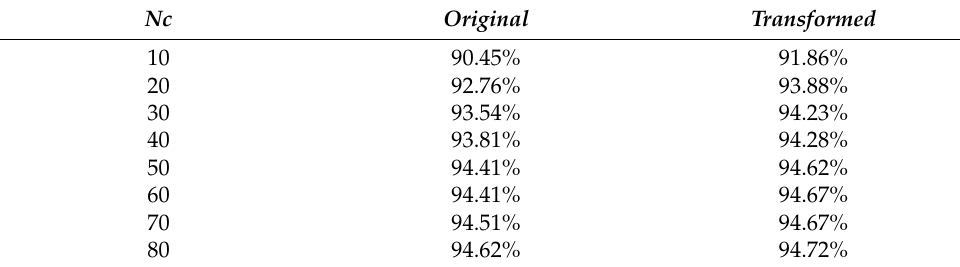
Table 5. User identification accuracy with and without transformation.